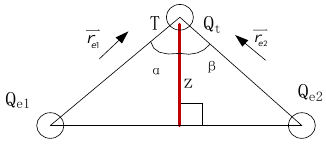
Figure 3. Schematic of electric field vector.